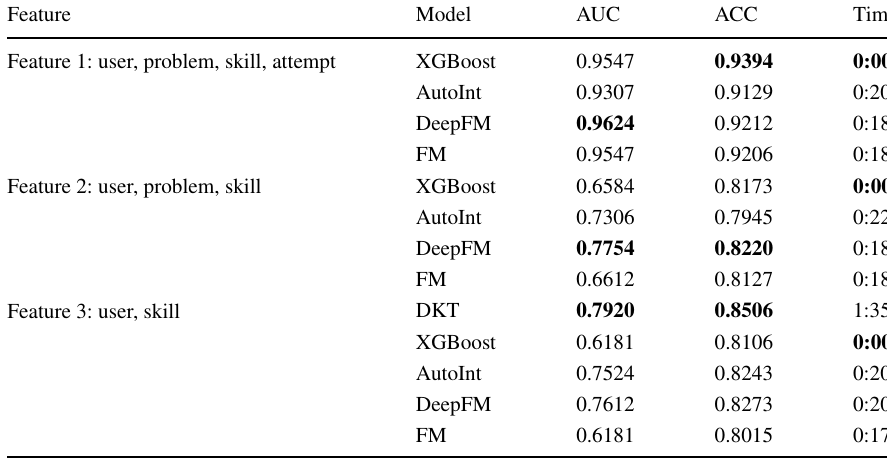
Table 9 The experimental results for Algebra08